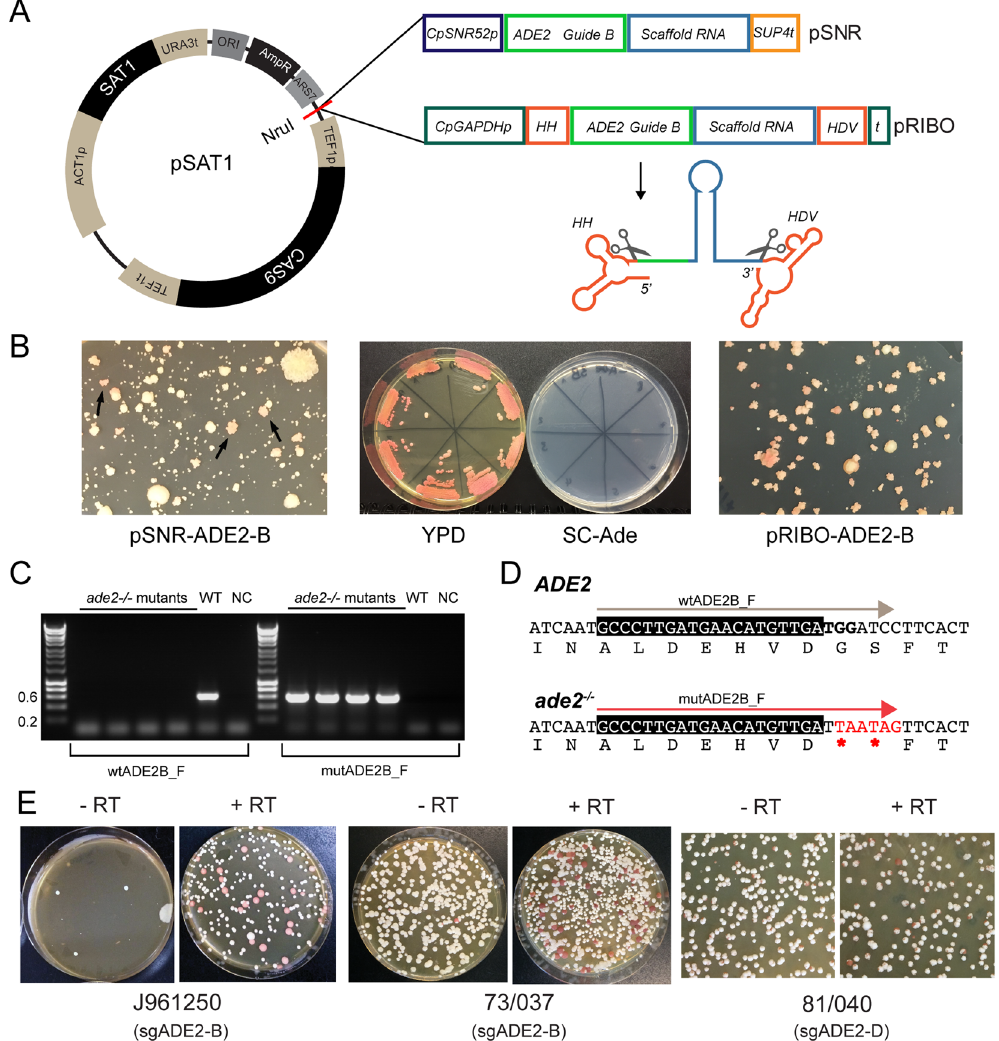
Figure 2. Editing ADE2 in C . parapsilosis using CRISPR. ( A ) Two constructs were generated by inserting one of two cassettes expressing a guide RNA targeting ADE2 at the NruI site of pSAT1. In the first cassette (pSNR), expression of the ADE2-B sgRNA is driven from the SNR52 promoter (dark blue), generating pSNR- ADE2-B. In the second cassette (pRIBO) the ADE2-B sgRNA is surrounded by two ribozymes (HH and HDV in red), and expression is driven from the GAPDH promoter (teal), generating pRIBO-ADE2-B. The scaffold sequence is shown in blue, the targeting sequence in green, the SUP4 terminator sequence in orange, and the GAPDH terminator in teal. Folding and cleavage of the guide RNA at the ribozyme sequences is shown below the pRIBO cassette. ( B ) Transformation of C . parapsilosis CLIB214 with pSNR-ADE2-B and a repair template (Supplementary methods) produced nourseothricin-resistant colonies of different sizes, including some that turned light pink after 3–5 days (black arrows, left). The pink color is more noticeable when streaked on YPD plates (middle). All pink colonies failed to grow in the absence of adenine (SC-ade). Transformation with pRIBO-ADE2-B produced colonies of more uniform size (right). ( C ) Pink colonies transformed with pSNR- ADE2-B were screened by PCR using one common primer (ADE2_REV) and one primer specific for either the wildtype (wtADE2B_F) or the mutant (mutADE2B_F) sequence, shown in gray and red in ( D ). A 631 bp PCR product was amplified from the mutant colonies only when the mutADE2B_F primer was used, and from the wildtype (WT) only when the wtADE2B_F was used. NC = no DNA. ( D ) Sequence of the ADE2 locus before and after the CRISPR-Cas9 mediated mutation. Following Cas9 induced cleavage, homologous recombination with a repair template results in the insertion of two stop codons in frame (shown in red) replacing the PAM site, thus disrupting the gene function. The gRNA sequence is highlighted with a black box, and the PAM sequence is shown in bold. The primers used in ( C ) are indicated above the sequences. ( E ) Transformation of clinical isolates of C . parapsilosis with the ribozyme plasmids pRIBO-ADE2-B (strains J961250 and 73/037) or with pRIBO-ADE2-D (strain 81/040). RT = repair